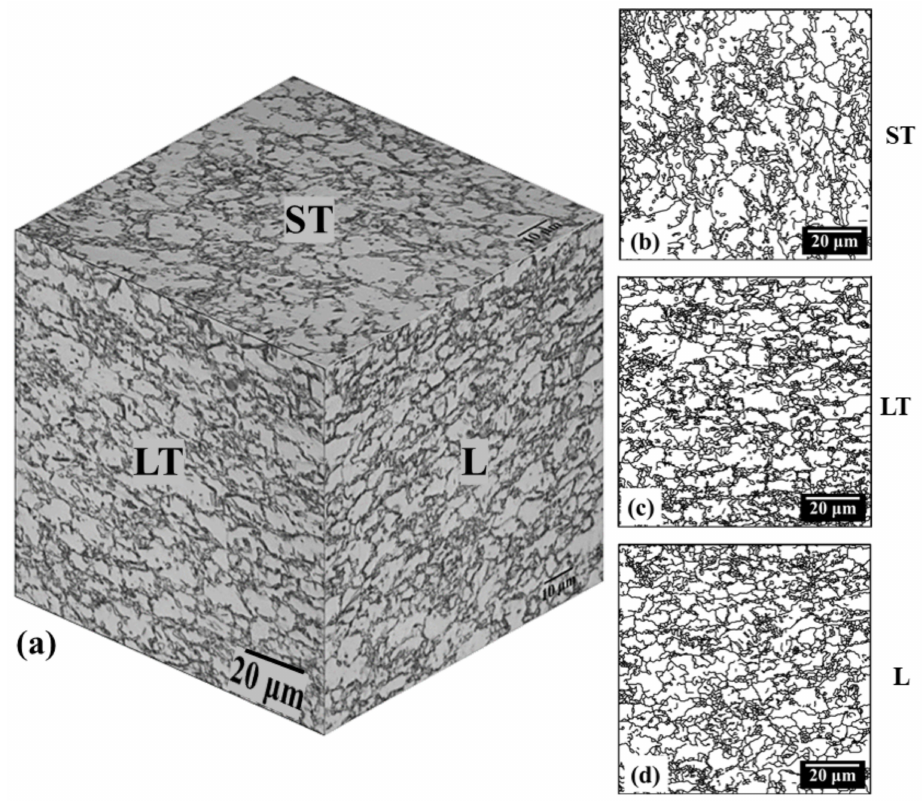
Figure 3. Microstructure of the DP980 steel sheet. ( a ) Three-dimensional view, ( b ) short transverse direction, ( c ) long transverse direction and ( d ) corresponds to the longitudinal to rolling